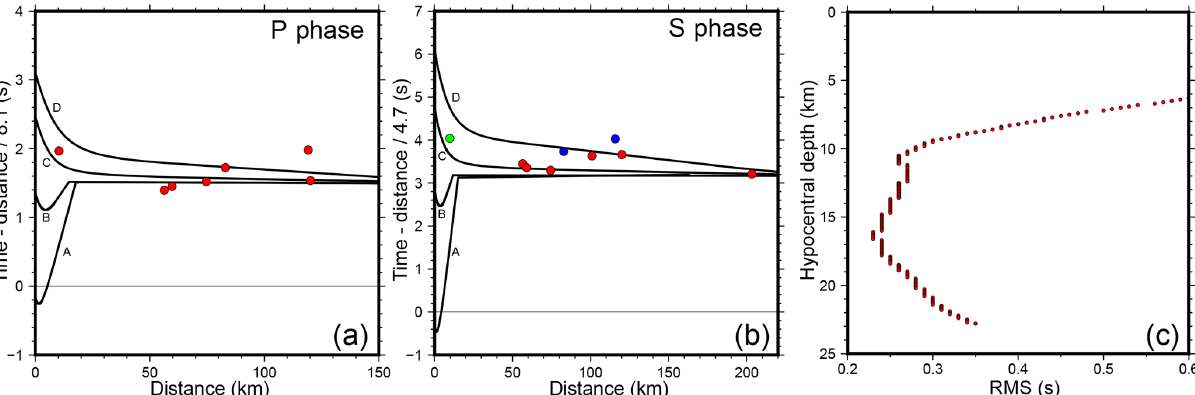
Figure A2. Panels (a) and (b) show the theoretical (black lines) and observed (coloured dots) first arrival times of the P and S phase for event 2. The colour code displays the picking weight from SEISAN: red – 0 best), green – 1, blue – 2. The theoretical arrival times were calculated for four different hypocentral depths: 6km for upper crust (A), 10km for lower crust (B), 16km (C) and 20km (D) both for upper mantle. Timings for A, B and D were manually adjusted so that the mantle phase is consistent in all cases. Panel (c) displays the uncertainty (RMS versus depth) for the absolute depth estimation of event 2. SEISAN package “rmsdep” was used (Havskov and Ottemoller, 1999, and references therein).